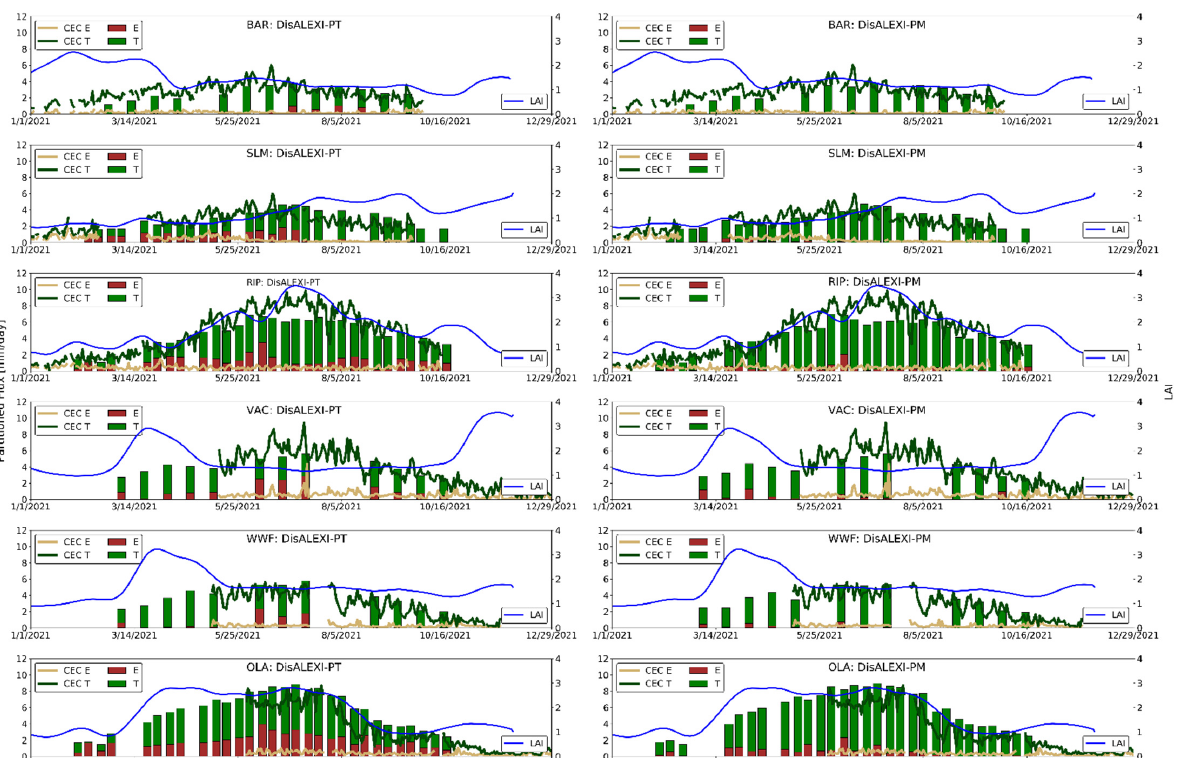
Figure 4. Time series of DisALEXI-PT-derived E and T (left brown and green bars, respectively) and DisALEXI-PM-derived E and T (right brown and green bars, respectively) on clear Landsat 8 overpass dates during 2021. Additionally included are CEC-derived daily estimated E and T (brown and green lines, respectively) and daily LAI (blue line).